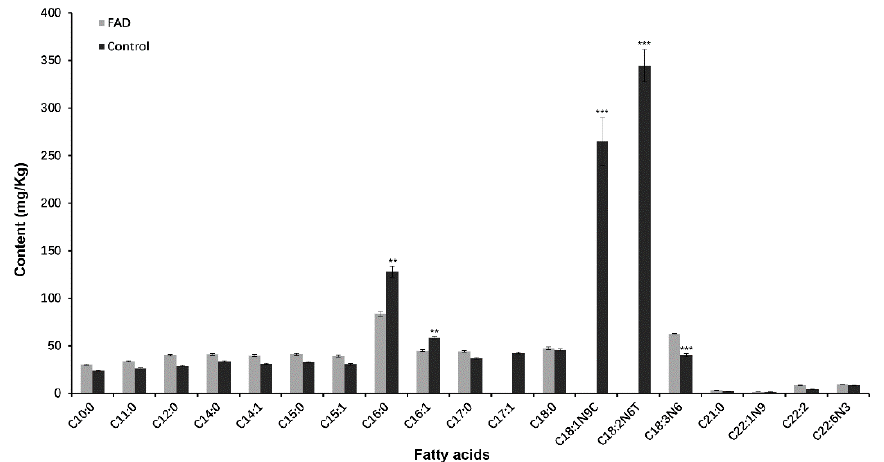
Figure 7. Determination of fatty acid in Pichia pastoris : Determination of fatty acid content in Pichia pastoris . Data are shown as means ± SD of three replicates (n = 3 × 3); Statistical significance analysis was carried out by performing Student’s t -test ( ** p < 0.01 and *** p <